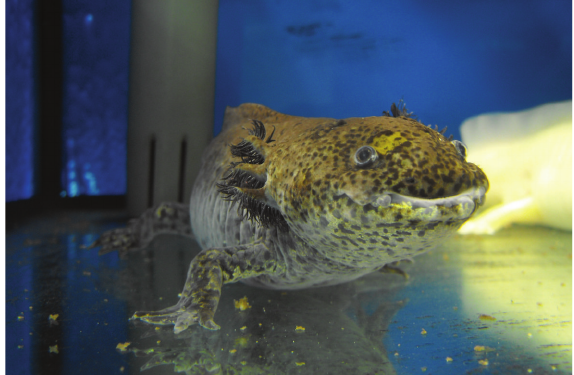
Figure 1: Axolotl or Mexican salamander ( Ambystoma mexicanum ), one of the few species that maintains the ability to regenerate its tail or limbs throughout its life. Karol Głąb/Wikipedia Creative